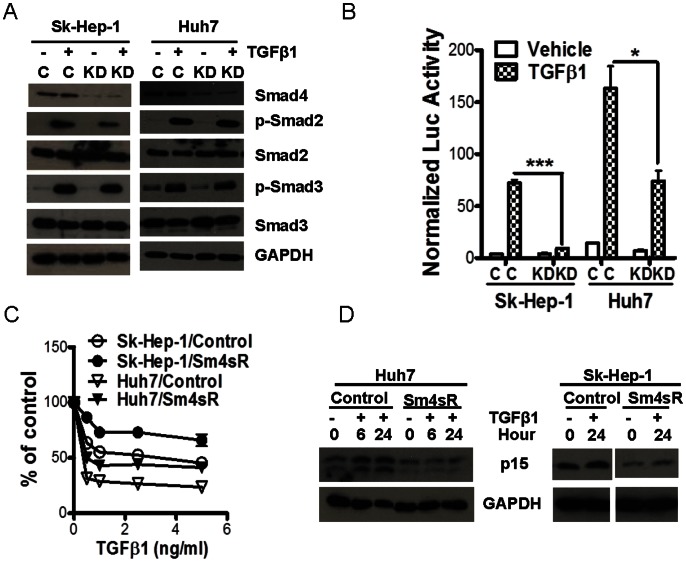
Smad-dependent inhibition of cell proliferation by TGF-β.(A) Immunoblotting analysis for Smad proteins and phosphorylated Smad2 and Smad3 was conducted in the cell lysates of control and Smad4-knockdown Sk-Hep-1 and Huh7 cells after treating the cells with TGF-β1 at 2 ng/ml for 1 hour. (B) SBE-luciferase assay was performed in Sk-Hep-1 and Huh7 cells transfected with or without Smad4 shRNA after TGFβ1 treatment as described in Fig. 2D. Each data point represents mean±SEM from three independent transfections. *, p<0.05; ***, p<0.001. (C) MTT assay was performed in Sk-Hep-1 and Huh7 cells with or without Smad4 knockdown after treatment with various concentrations of TGFβ1 for 5 days. (D) Immunoblotting analysis of p15 expression was carried with lysates from Sk-Hep-1 and Huh7 cells with or with Smad4 knockdown after treatment with TGFβ1 at 5 ng/ml for indicated time periods when the culture was 70–80% confluent.